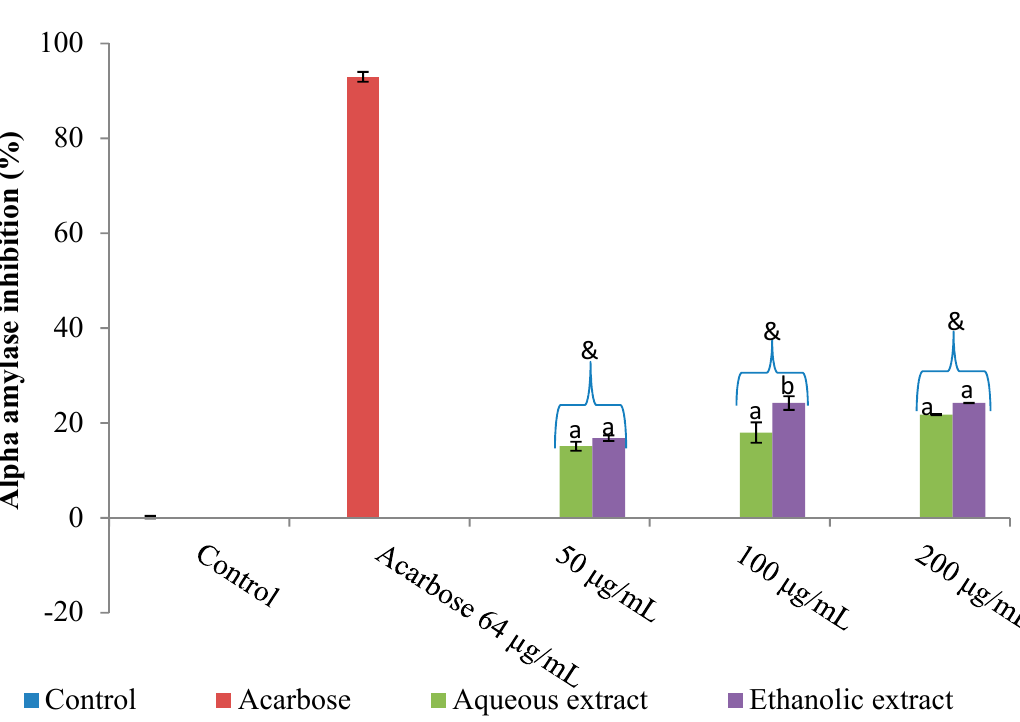
Figure 1. Bar chart showing the inhibition of α‐ amylase by aqueous and ethanolic extracts of Vernonia mespilifolia . The values in the bar chart are expressed as mean ( α‐ amylase inhibition) ± standard deviation (SD) (n = 5). Mean separation was done by Least Significant Difference (LSD) ( p < 0.05). Sets of bars (the same concentration) with different alphabets are significantly different; p < 0.05. & Less than acarbose (positive control).